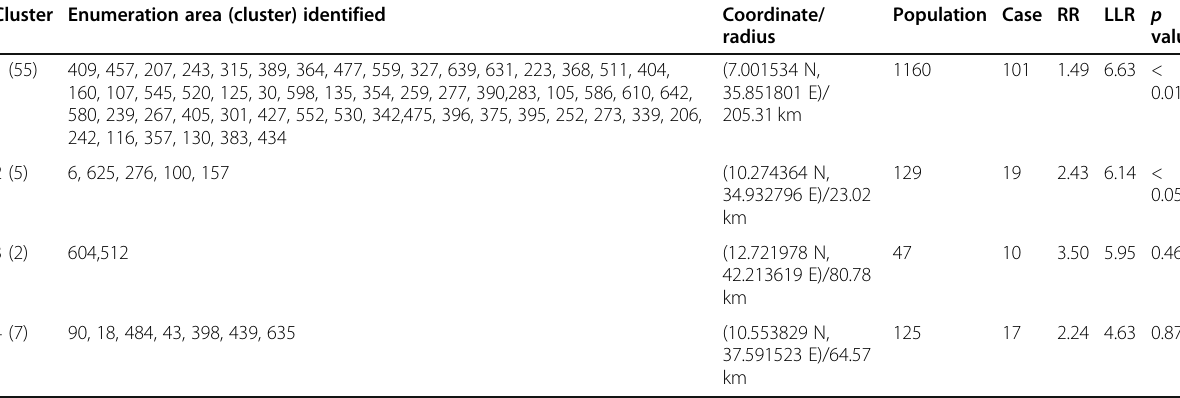
Table 4 Spatial scan statistical analysis of hotspot areas of infant mortality in Ethiopia, 2011 Cluster Enumeration area (cluster) identified Coordinate/